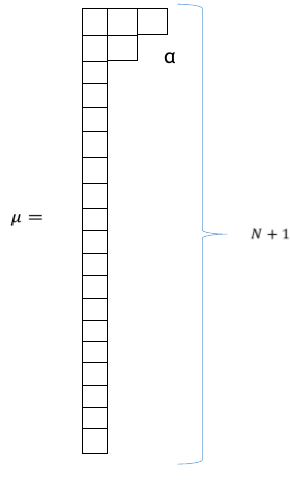
Figure 1 . Typical Young diagram for states of the second phase. Here j (cid:11) j = n 0 .